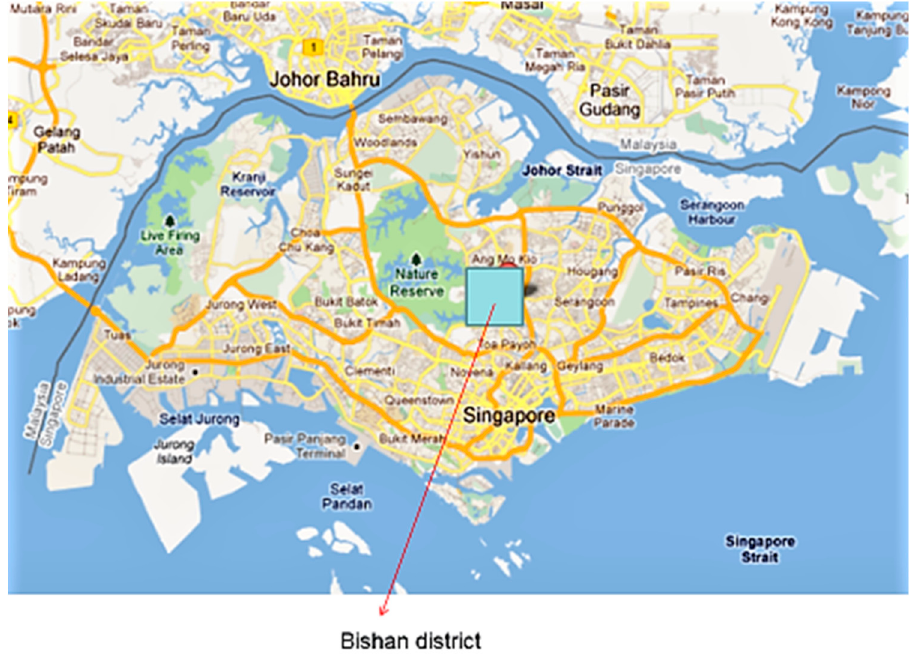
Figure 1. Location of Bishan District in